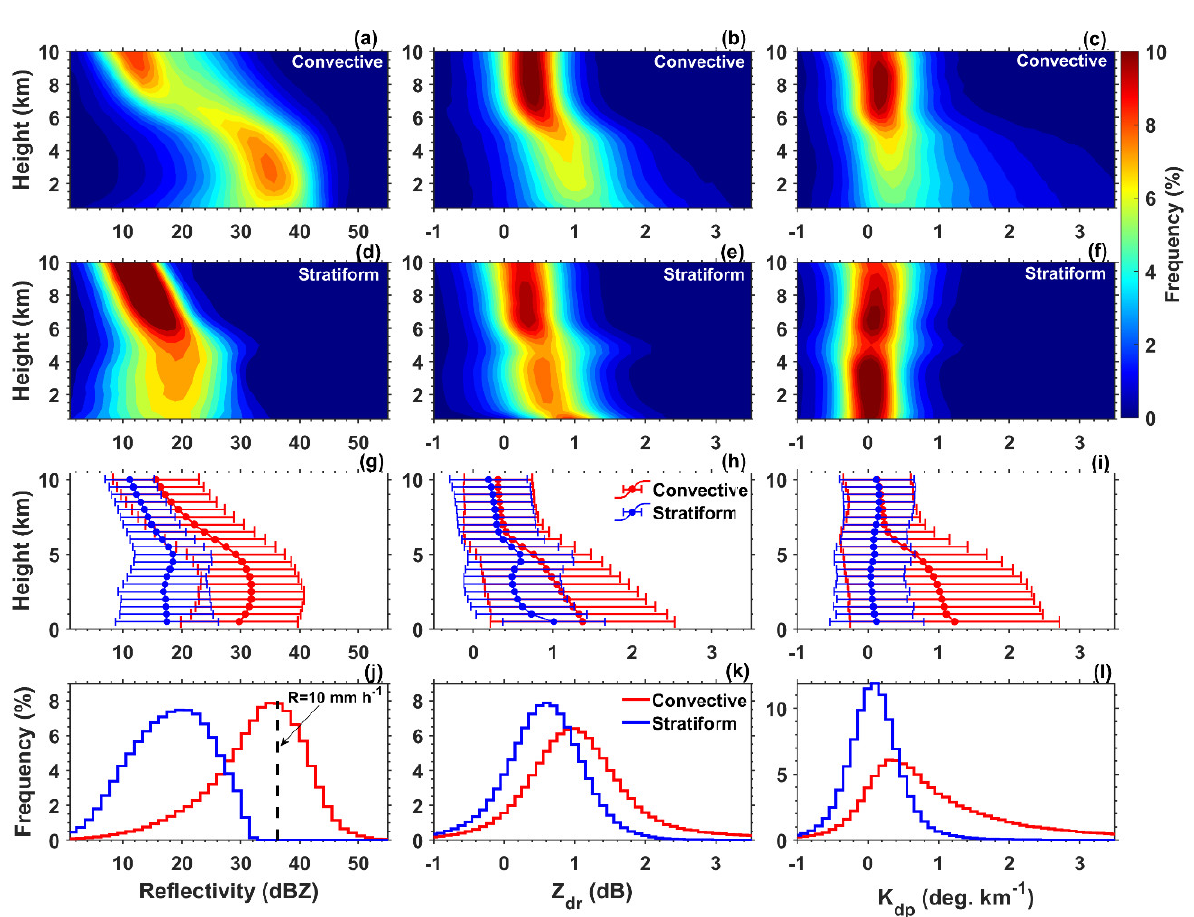
Figure 6. Contour frequency by altitude diagram (CFAD) of Z h , Z dr and K dp for convective ( a – c ) and stratiform ( d – f ) regions. ( g – i ) Mean vertical profile with 1-σ error bars of Z h , Z dr and K dp over convective (red) and stratiform (blue) regions. ( j – l ) Frequency distribution of Z h , Z dr and K dp at 3 km height. The black dotted line represents rain rate of 10 mm h −1 .